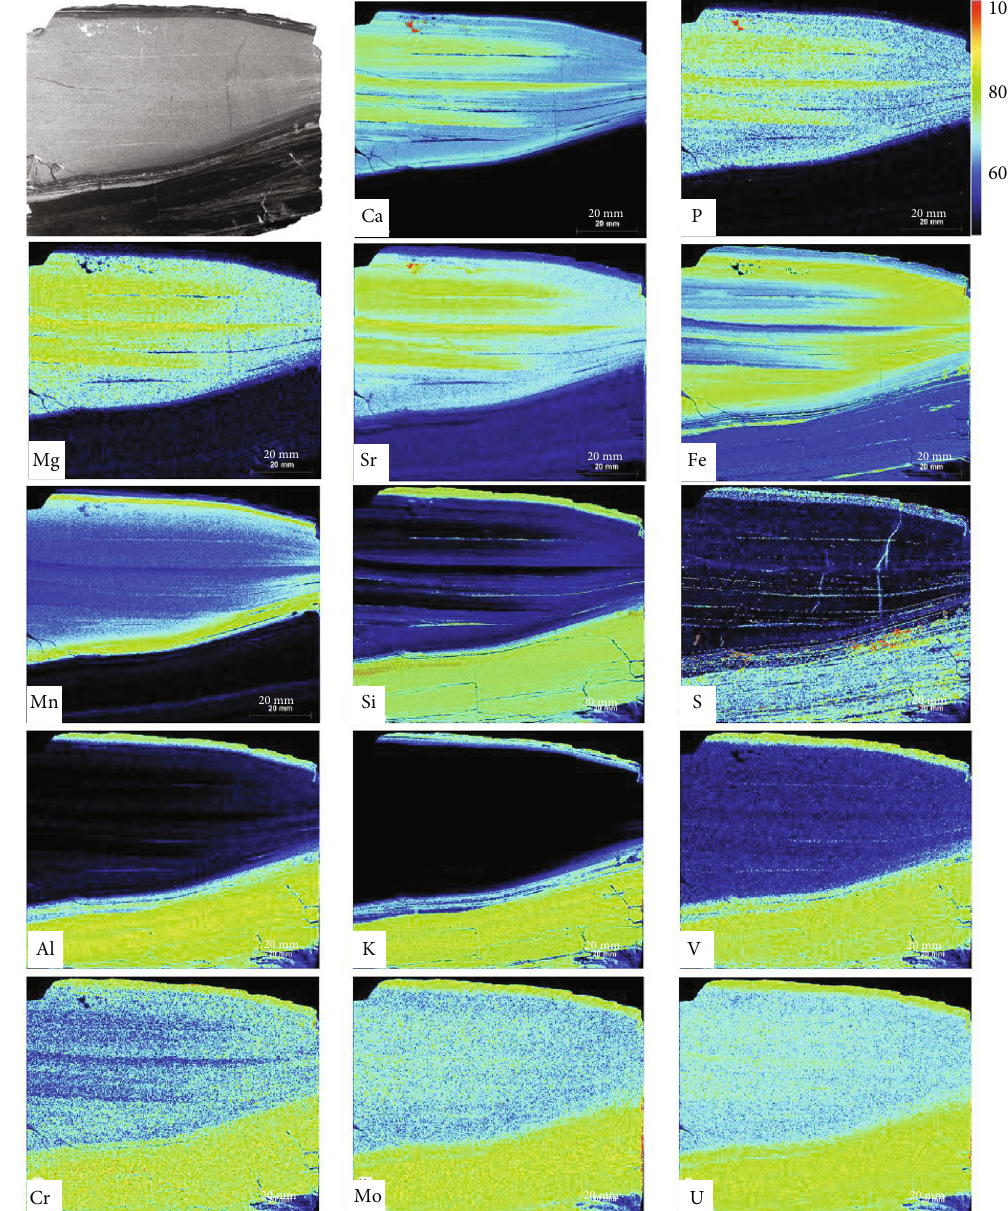
Figure 10: Multielement imaging of dolomite nodule and host shale by using XRF. Image size 95 : 248 × 73 : 891 mm ( 3810 × 2956 pixels); 25 μ m pixel size; 4ms exposure time per pixel. All images share the same color